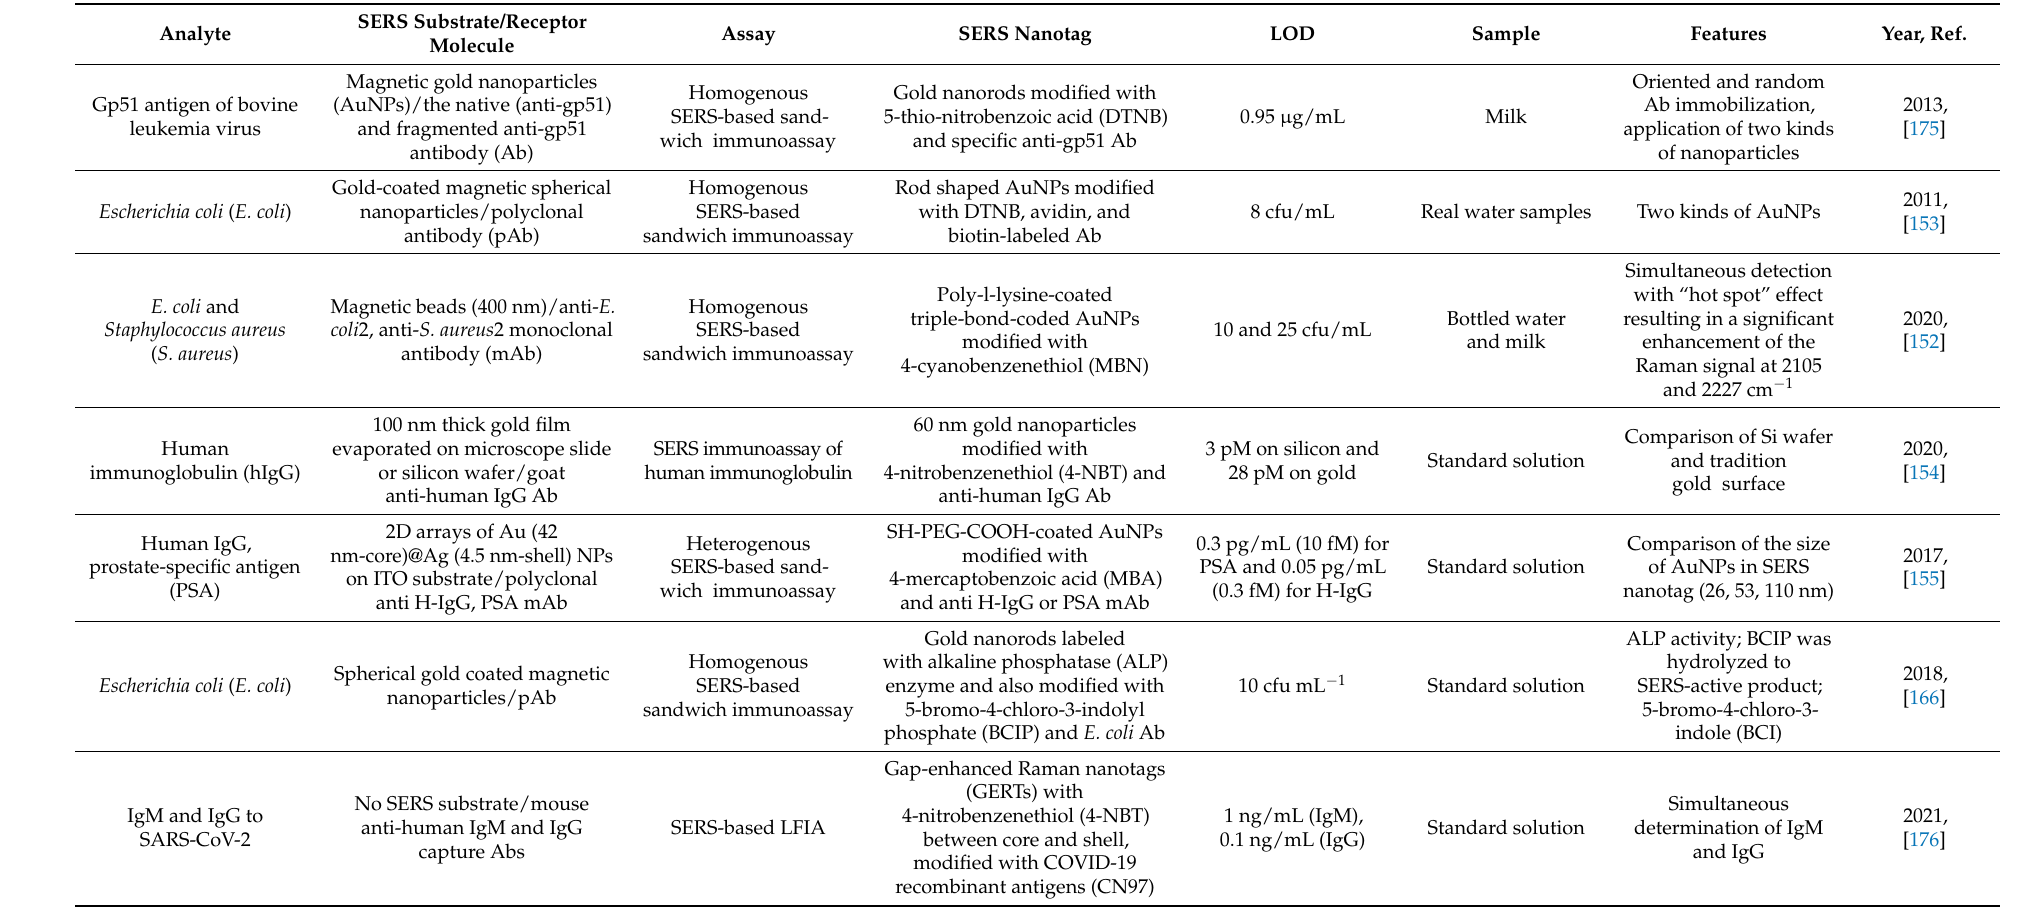
Table 3. Indirect biosensing using SERS